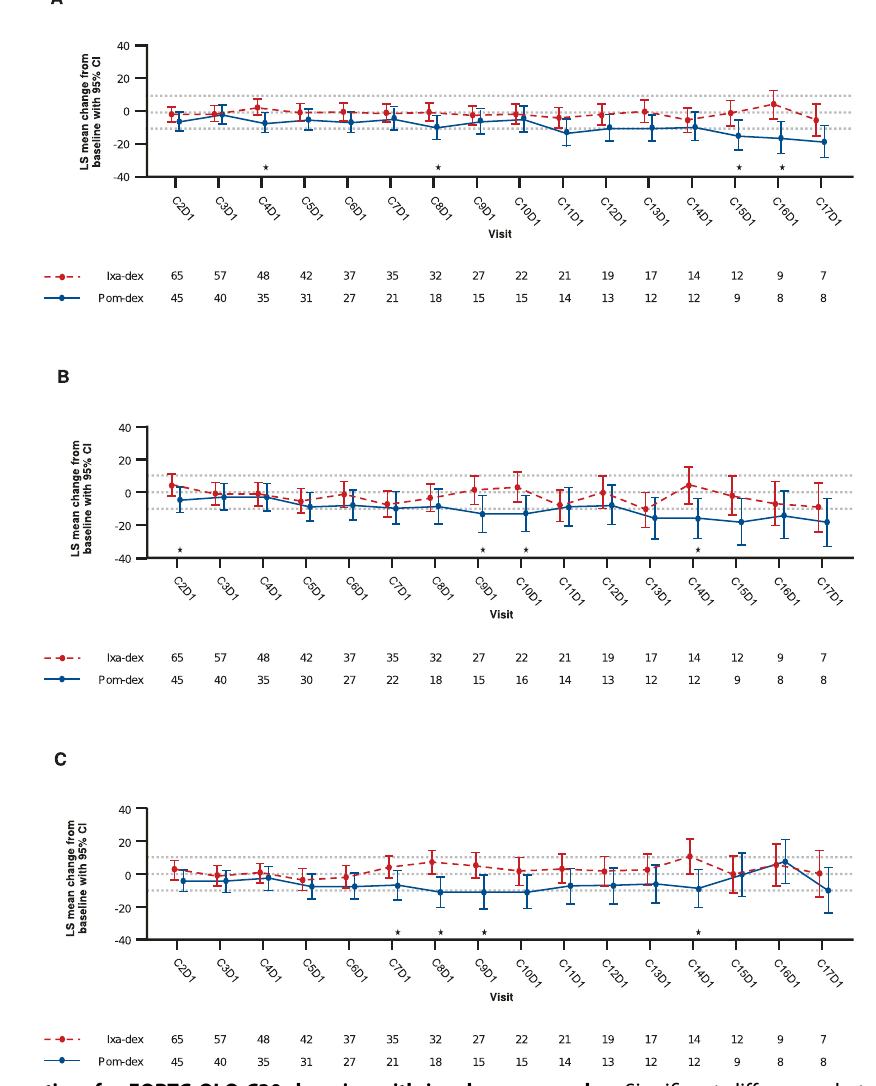
Fig. 4 Mean scores over time for EORTC QLQ-C30 domains with ixa-dex vs pom-dex. Signi fi cant differences between arms were seen at multiple time points: ( A ) cognitive functioning, ( B ) insomnia, and ( C ) diarrhea in patients on the ixa-dex and pom-dex arms. C Cycle, D1 Day 1, dex dexamethasone, CI con fi dence interval, ixa ixazomib, LS least squares, pom pomalidomide. * Indicates P ≤